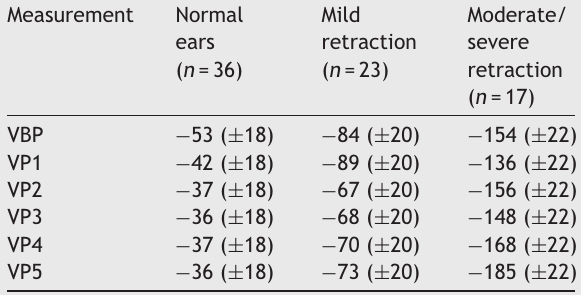
Estimated means obtained with a linear mixed model for the Valsalva maneuver in the three groups, at the second time point of